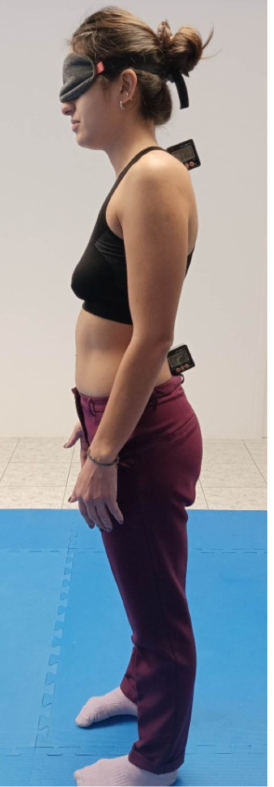
Figure 2. Initial position and placement of the